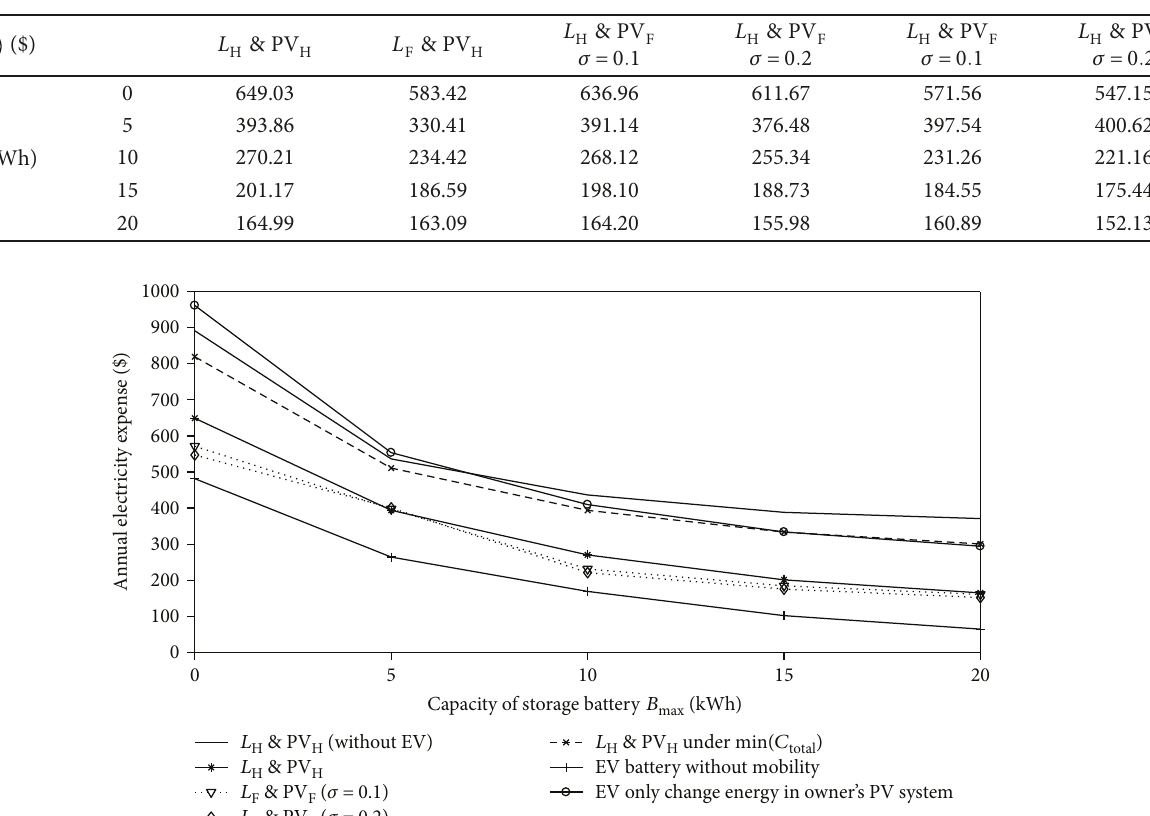
ff erent inputs. i with di